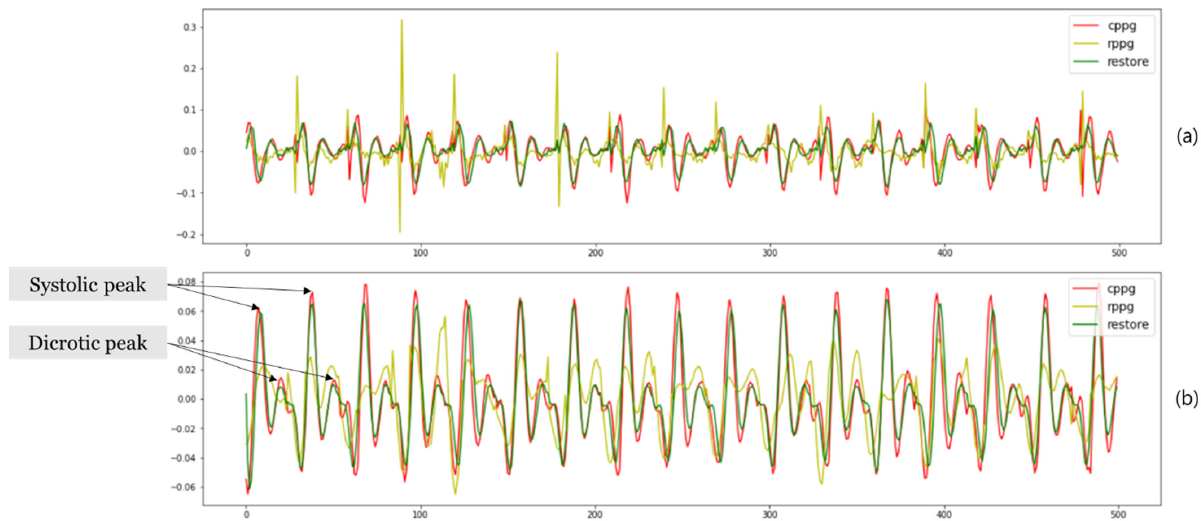
Table 4. The mean SD-PPTs and paired t -test results of SD-PPTs of three 23-year-old subjects.